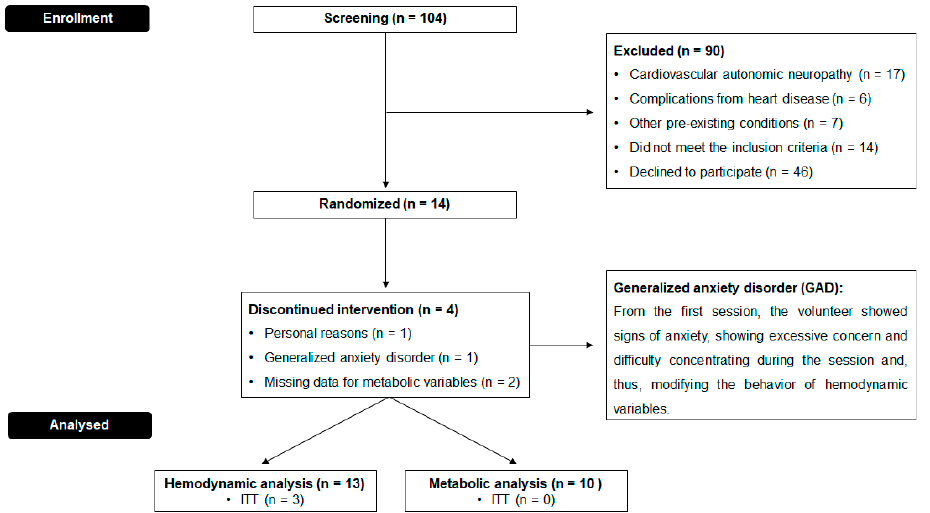
Figure 3. Flowchart (CONSORT). A total of 104 subjects who met the inclusion criteria were included in the study from November 2018 to December 2019. Ninety subjects were excluded due to the exclusion criteria; seventeen with cardiovascular autonomic neuropathy; six with complications from heart disease; seven with other pre-existing conditions; fourteen did not meet the inclusion criteria and forty-six dropped out due to long evaluation periods but, before randomizing. In total, 14 subjects were randomized, one was excluded due to personal reasons, one was excluded due to generalized anxiety disorder during the sessions and two because of missing data. In total, ten par- ticipants completed the study. Moreover, we included three subjects in the intention to treat (ITT) them for hemodynamic analysis.